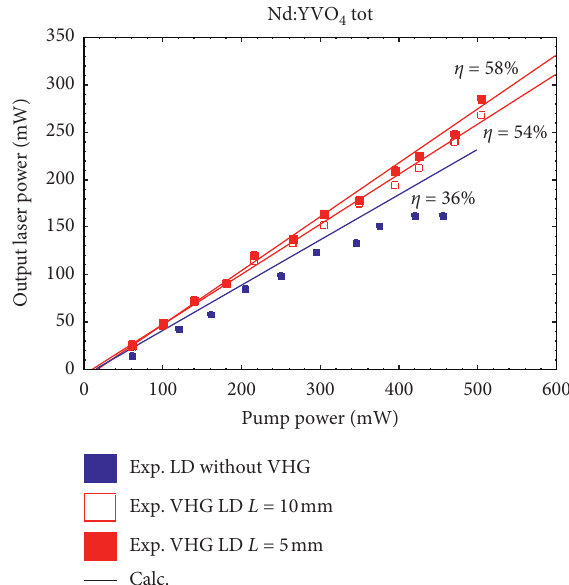
Figure 3: Output laser power of Nd:YVO